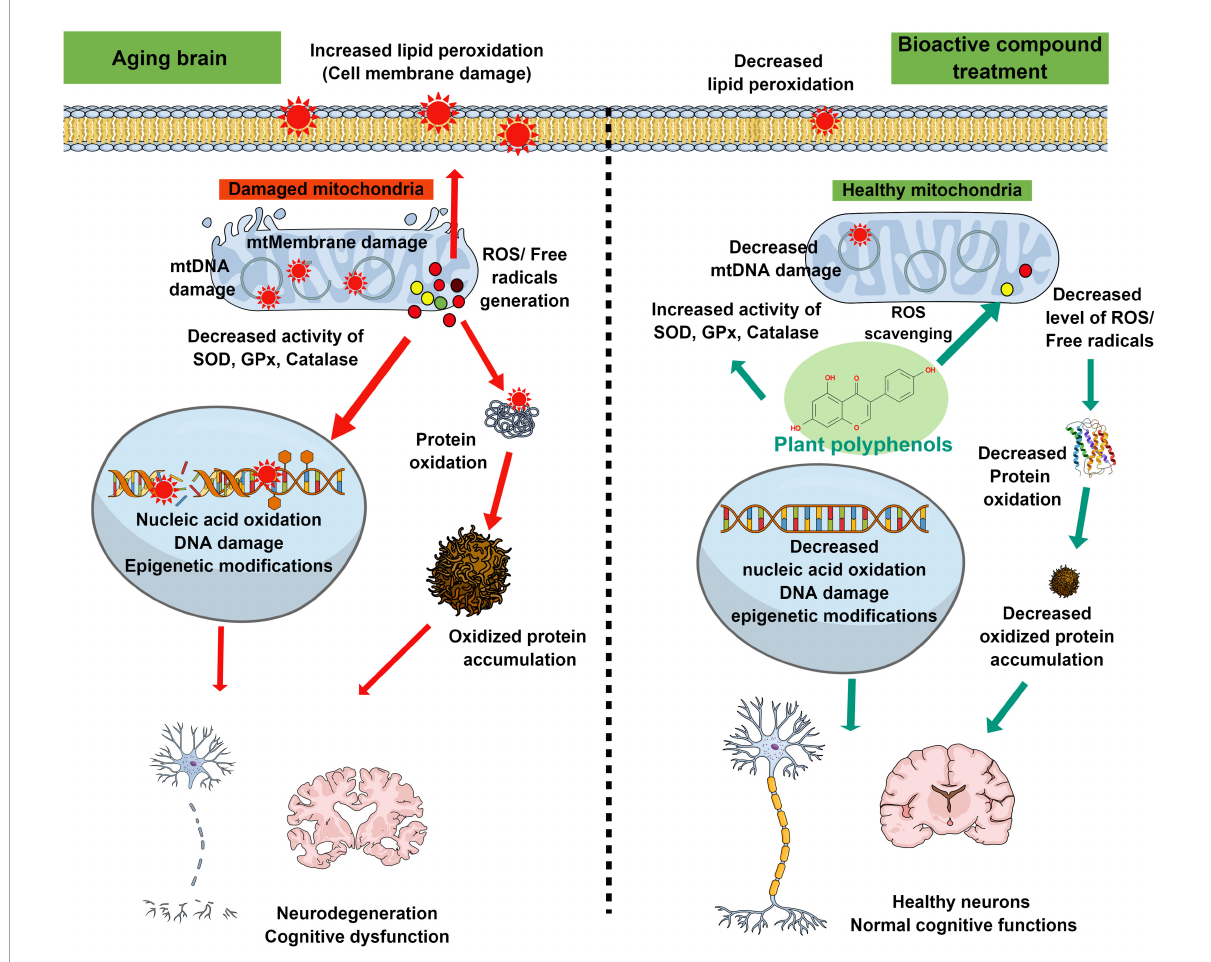
FIGURE2 Schematic diagram representing the antioxidant properties of plant-derived bioactive compounds in the recovery of oxidative stress-mediated changes in the aging brain. Age-associated cellular and biochemical changes such as mitochondrial dysfunction, and decline of antioxidant enzyme systems lead to the generation of excessive reactive free radicals. These free radicals cause changes in the biological macromolecules (lipid peroxidation, oxidation of protein, and nucleic acid) and thus facilitate cellular or mitochondrial membrane damage, modified protein accumulation, double-stranded DNA break, and epigenetic modifications. These oxidative stress-mediated damages ultimately lead to neurodegeneration and decline of cognitive functions during aging or associated neurodegenerative diseases. Supplementation of plant-derived bioactive compounds ameliorates the age-associated neurodegeneration and cognitive dysfunctions by increasing the activities of antioxidant enzymes and decreasing the oxidative stress-induced damages to biological